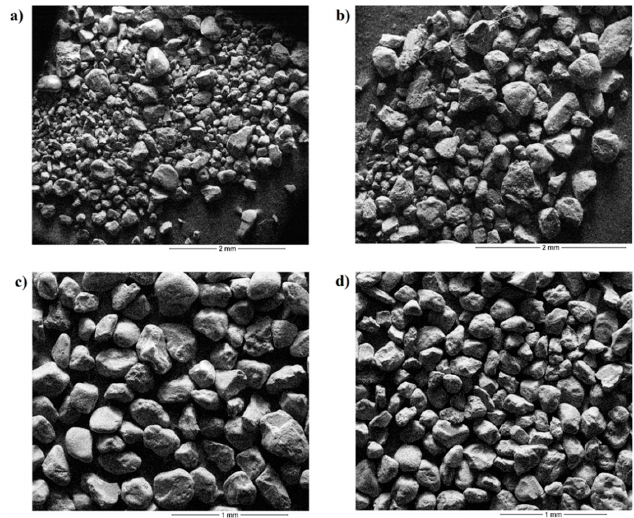
Figure 9. SEM photograph: ( a ) dust 3 (magnification 26×), ( b ) dust 4 (magnification 34×), ( c ) dust 5 (magnification 53×), ( d ) dust 6 (magnification 49×).